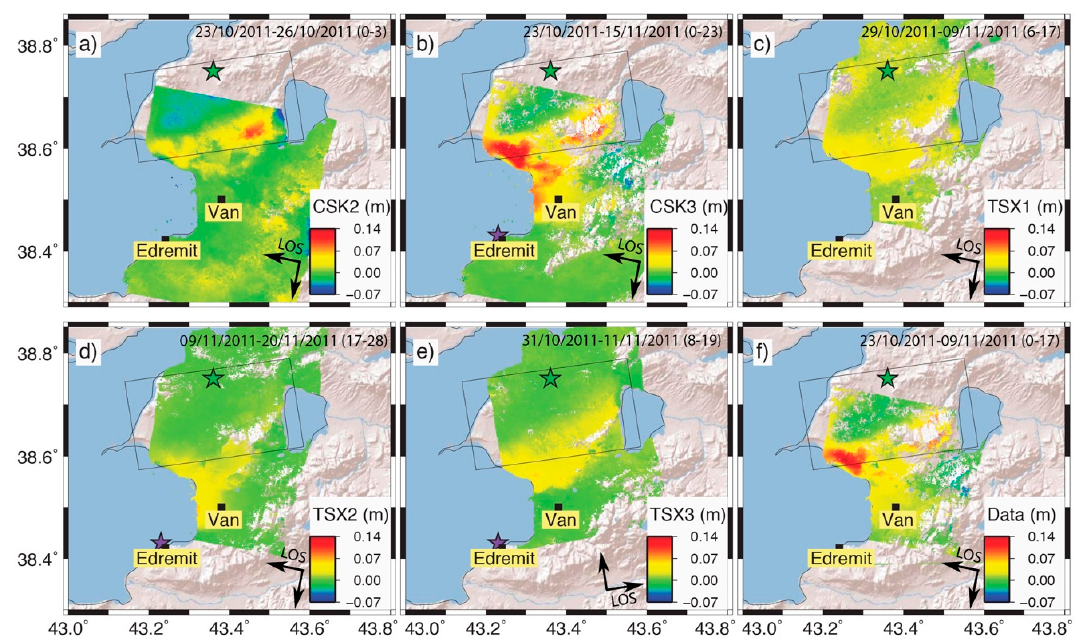
Figure 8. Post-seismic InSAR results from CSK and TSX satellites: ( a ) CSK2; ( b ) CSK3; ( c ) TSX1; ( d ) TSX2; ( e ) TSX3; and ( f ) difference between CSK3 and TSX2 (see text and Table 1 for details). Master/slave dates are indicated, along with the days after the mainshock in brackets. The green star is the mainshock epicenter and the purple star is the Edremit-Van earthquake epicenter (shown only if included in the temporal baseline).